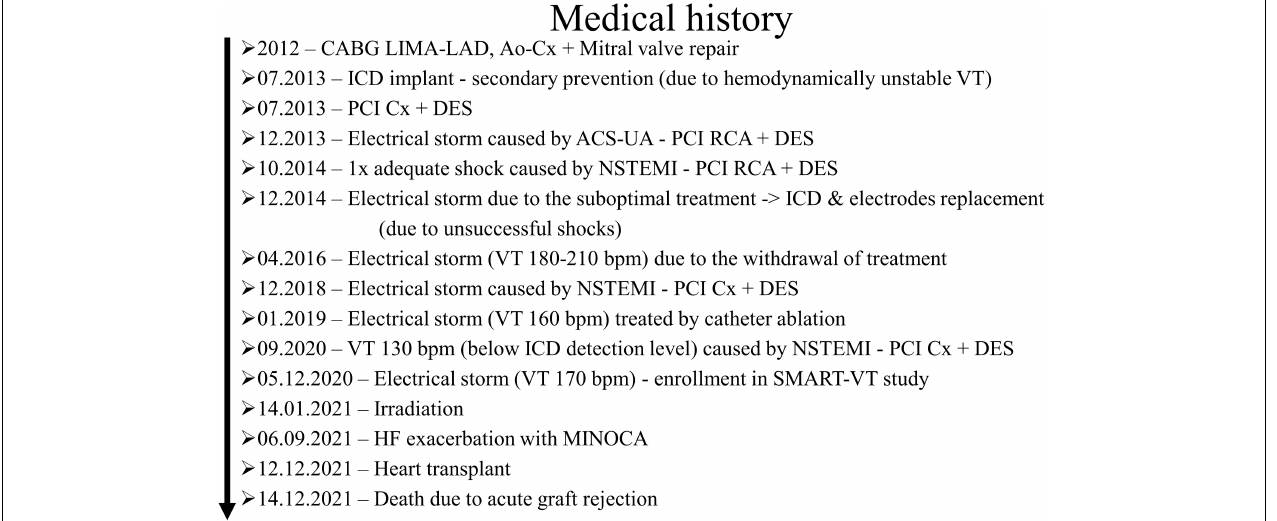
FIGURE 1 | Medical history of the patient treated with STereotactic Arrhythmia Radioablation (STAR). CABG, coronary artery bypass graft surgery; LIMA-LAD, left internal mammary artery – left anterior descending coronary artery; Ao, aortic root; Cx, circumflex branch of the left coronary artery; ICD, implantable cardioverter defibrillator; VT, ventricular tachycardia; PCI, percutaneous coronary intervention; ACS-UA, acute coronary syndrome – unstable angina; DES, drug eluting stent; RCA – right coronary artery; NSTEMI, non-ST-elevation myocardial infarction; MINOCA, myocardial infarction with non-obstructive coronary arteries.